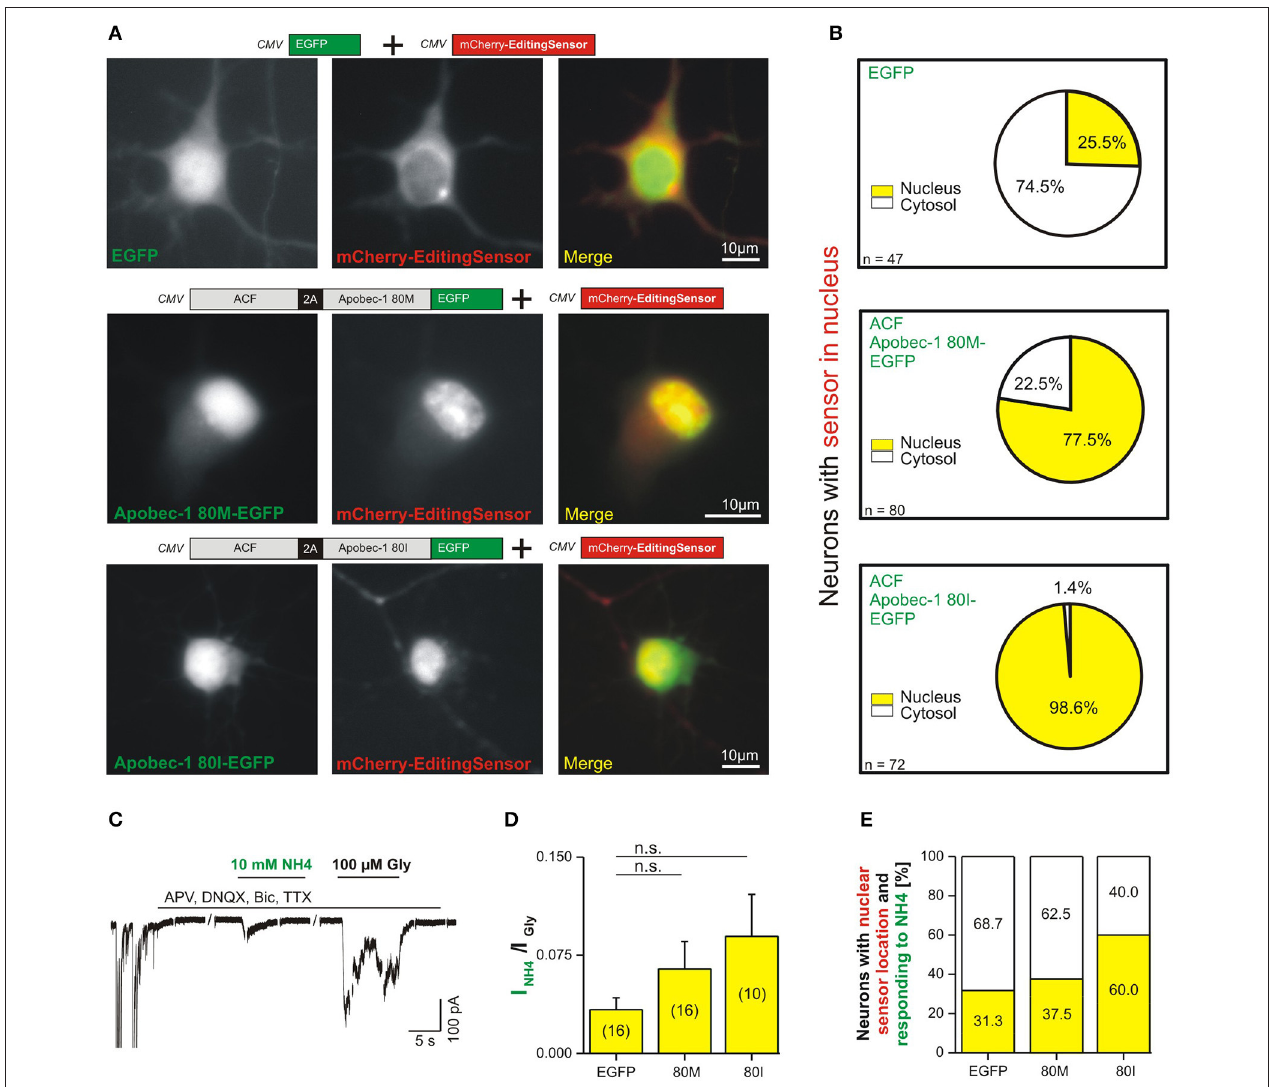
FIGURE 6 | Application of 10mM NH 4 reveals endogenous expression of RNA-edited GlyR protein in primary hippocampal neurons. (A) We co-transfected here the mCherry editing sensor either without Apobec-1 (EGFP, control) or with EGFP-tagged ACF-Apobec-1 80M or 80I to check the nuclear localization of the ectopically expressed human Apobec-1 protein in RHC neurons. Representative images document preferential cytosolic localization of the editing sensor in neurons co-transfected with EGFP (control, upper panel). In contrast, co-expression of Apobec-1 80I or 80M variants triggered nuclear localization of the editing sensor. (B) Quantification of the fraction of neurons with editing sensor in nucleus vs. cytosol in the three different conditions. (C) The example trace shows NH 4 responsiveness of a neuron expressing Apobec-1 80I. Spontaneous neuronal activity was acquired for control purpose (left-hand) and blocked using TTX, APV and DNQX, and bicuculline (BIC) during acquisition of responses to 10mM NH 4 . (D) Quantification of the ratio of peak amplitudes of 10mM NH 4 - and 100 µ M glycine-evoked currents in EGFP (control) or Apobec-1 80M or 80I overexpressing neurons with nuclear sensor localization, representing C-to-U RNA editing-competent neurons. Statistical analysis using Mann-Whitney test did not reveal significant differences (“n.s.”, P > 0.05); the number of investigated neurons is indicated in brackets. (E) Quantification of the fraction of neurons with nuclear editing sensor localization and NH 4 -responsiveness reveals an Apobec-1 80I-dependent increase of the expression of RNA-edited GlyR protein (31.3 vs. 60.0%). Note that a NH 4 -responsive neuron was determined if the amplitude ratio between 10mM NH 4 - and 100 µ M glycine-evoked currents was above 0.033 (EGFP control